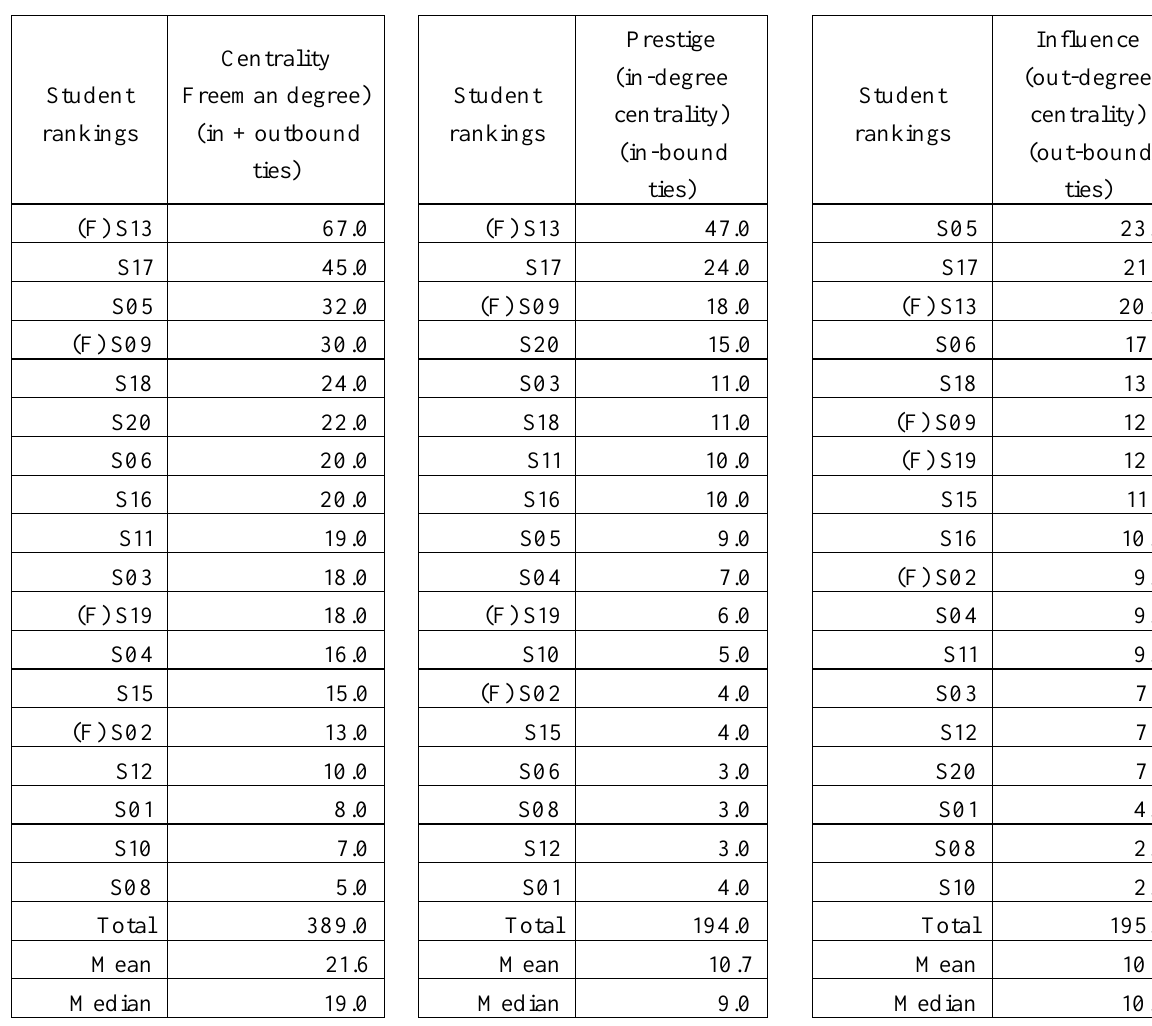
Rankings of Student Measures of Centrality, Prestige, and Influence for all Module 6